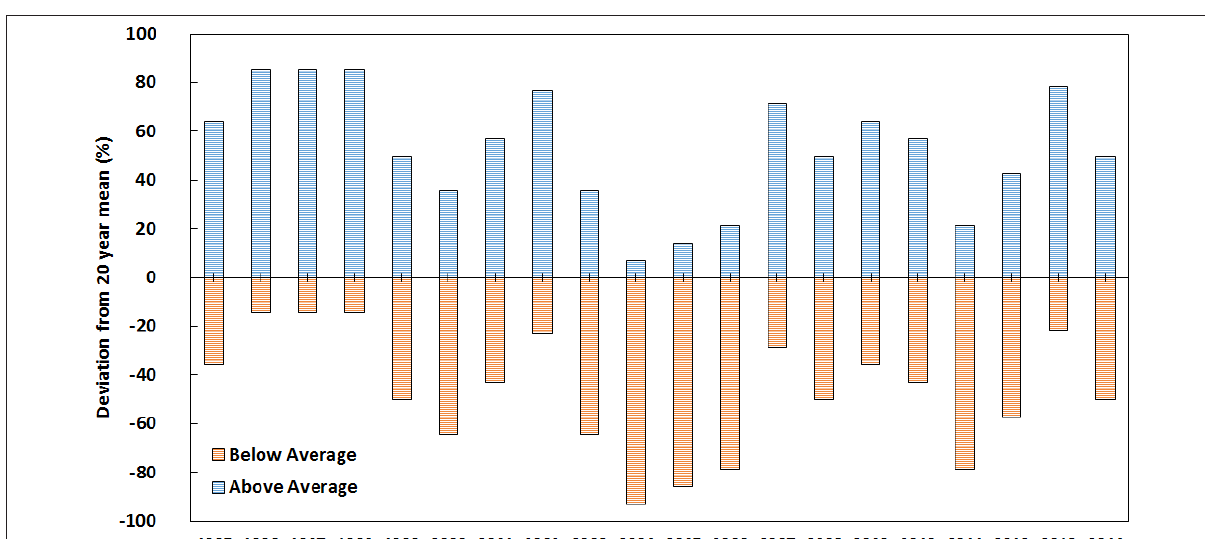
Figure 4: Deviation from mean wind speeds for the period